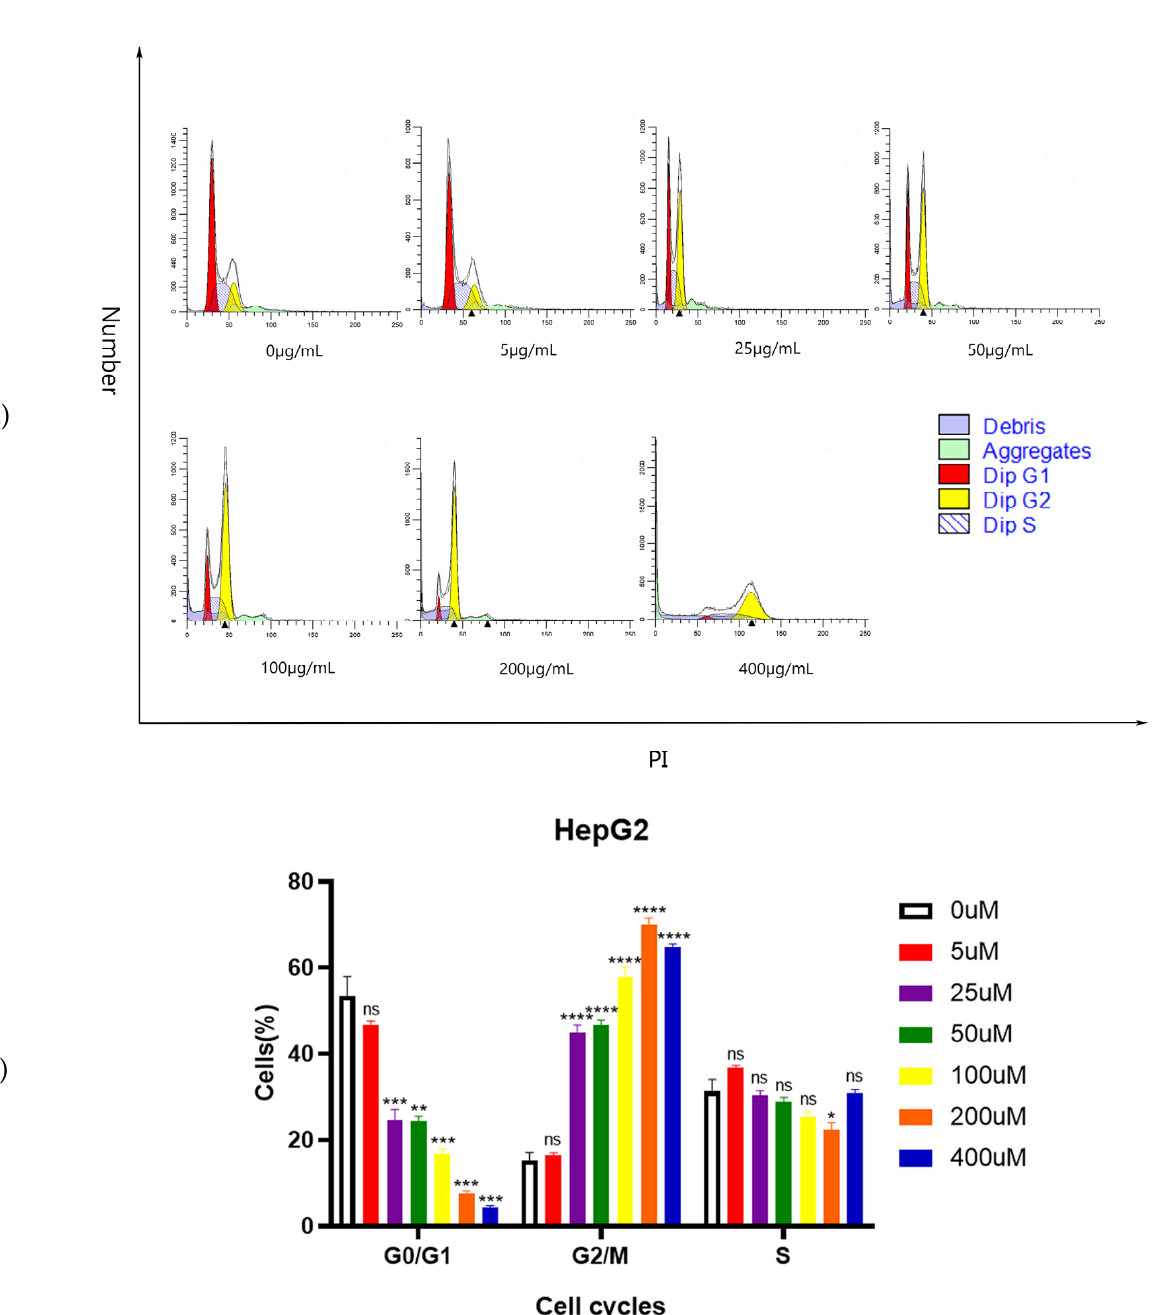
Figure 6. The cell cycle of HepG2 cells induced by Se-MOP (0, 5, 25, 50, 100, 200, and 400 μ g/mL). ( A ) Flow cytometric analysis of HepG2 cells after being treated with different concentrations of Se- MOP (0, 5, 25, 50, 100, 200, and 400 μ g/mL) for 24h. The red color region represents the G1 phase (a period from mitosis to DNA replication, which mainly synthesizes RNA and ribosomes.); the yellow color region represents the G2 phase (a late stage of DNA synthesis and a preparation period for mitosis, in which a large amount of RNA and proteins are synthesized.); slash with blue color region represents the S phase (the DNA synthesis period and histone synthesis). ( B ) Histogram of HepG2 cells percentage in a different cell cycle phase after treatment with different Se-MOP concentrations (0, 5, 25, 50, 100, 200, and 400 μ g/mL) for 24 h. All values are expressed as mean ± SD at least three independent experiments. * p < 0.05, ** p < 0.01, *** p < 0.001, **** p < 0.0001 vs. the control group.